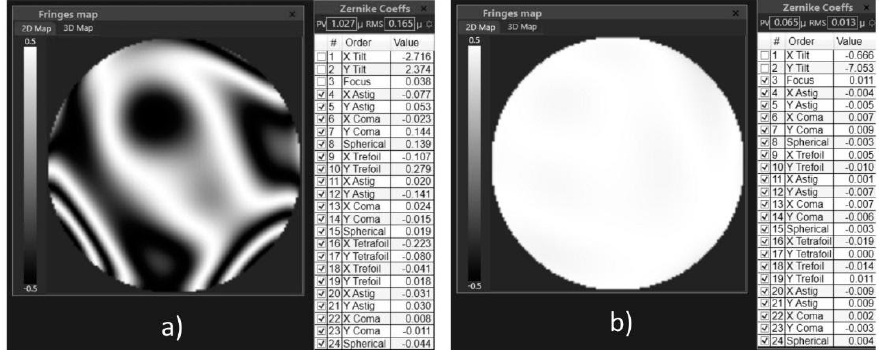
Figure 4. The DM surface shape in terms of interferogram and expansion in Zernike polynomials (#—ordinal number of the Zernike polynomial): ( a ) the initial surface after manual correction without taking into account the curvature, P-V = 1.03 μ m, RMS = 0.17 μ m; ( b ) surface after aberrations correction in the closed-loop, P-V = 0.07 μ m, RMS = 0.01 μ m.